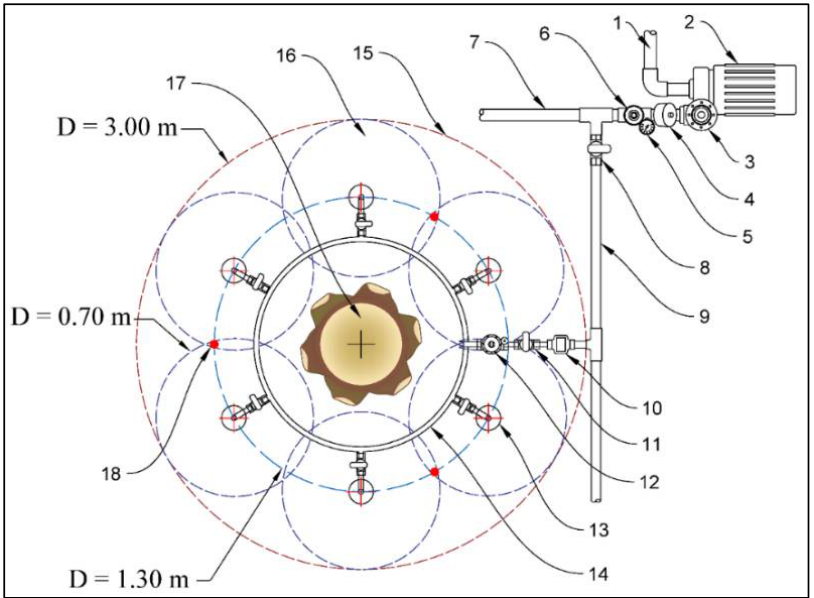
Figure 3. Typical layout of the six subsurface irrigation units distributed around the date palm tree.